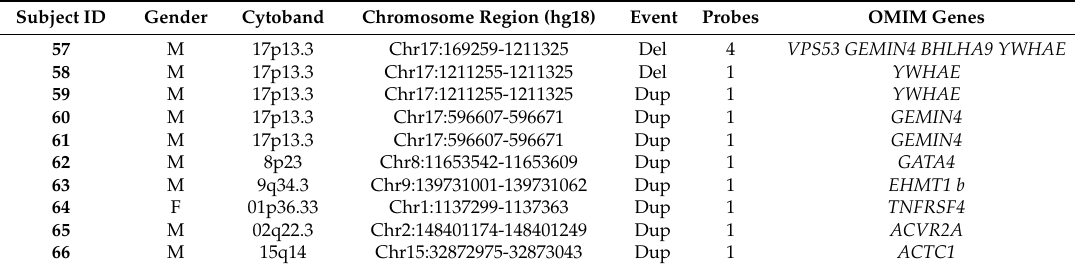
Table 2. CCHD patients with imbalances out off the 22q11 region